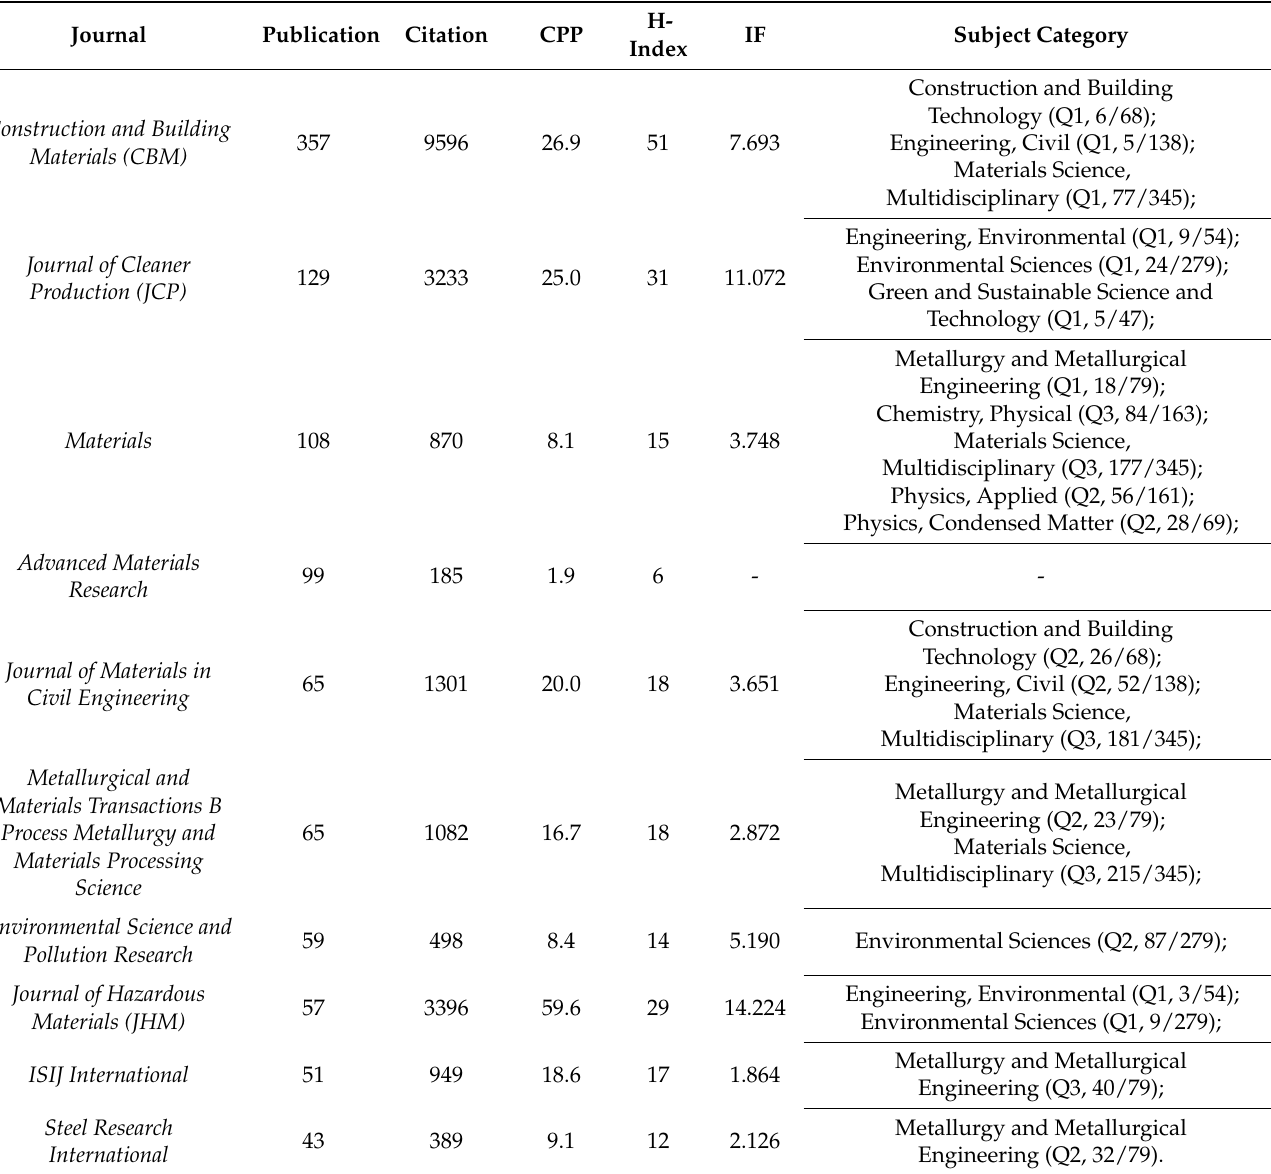
Table 1. The top 10 productive journals in the field of steel